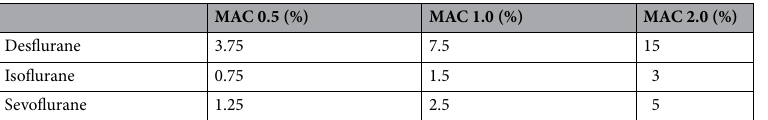
Table 1. Concentrations of inhaled anesthetics based on MAC values adapted from Thiel & Roewer’s “Anästhesiologische Pharmakotherapie” used in this study 7 . MAC minimal alveolar